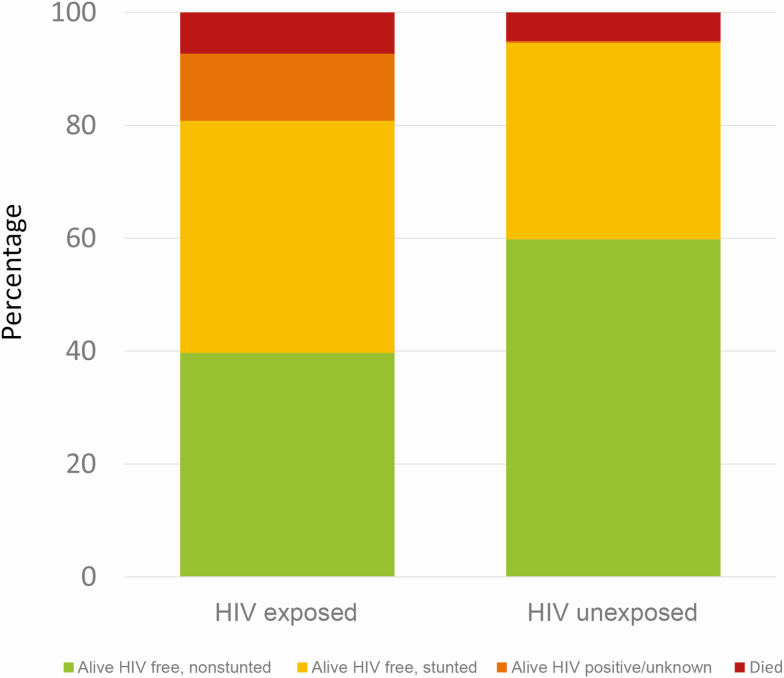
Proportion of children who were alive, human immunodeficiency virus (HIV) free, and nonstunted at 18 months. Only children in non–infant and young child feeding trial arms were included. HIV exposed, n = 371; HIV unexposed, n = 1956. Among 1956 children who were HIV unexposed, 21 children were born to mothers who tested HIV negative in pregnancy but HIV positive at 18 months postpartum, meaning they became HIV exposed during breastfeeding; of these, 5 of 1956 (0.26%) were HIV positive at 18 months and 1 of 1956 (0.05%) was HIV unknown. Among the 1927 HIV-negative mothers of the 1956 children who were HIV unexposed, 266 (14%) did not undergo repeat HIV testing at 18 months; it is therefore possible that additional children in the HIV-unexposed group became postnatally exposed and therefore infected. The HIV incidence among groups tested was 1.2%, and HIV transmission occurred in 21% of children born to postpartum seroconverting mothers. Assuming similar circumstances, approximately 3 of the 266 mothers may have been HIV positive at 18 months, and there would be < 1 expected vertical transmission.